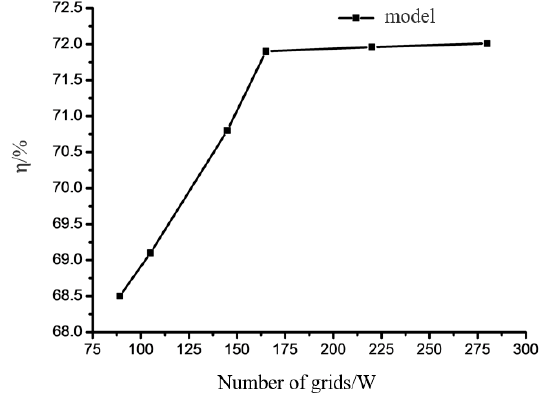
Figure 5. Grid independence verification.